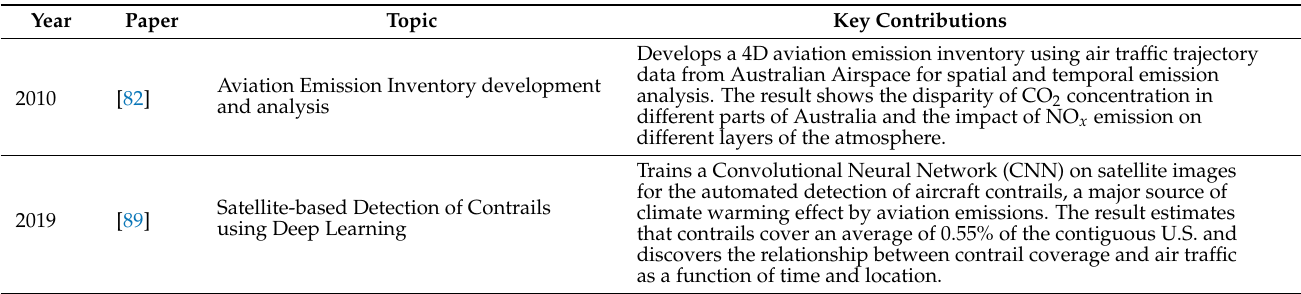
Table 6. Summary of representative papers in pattern